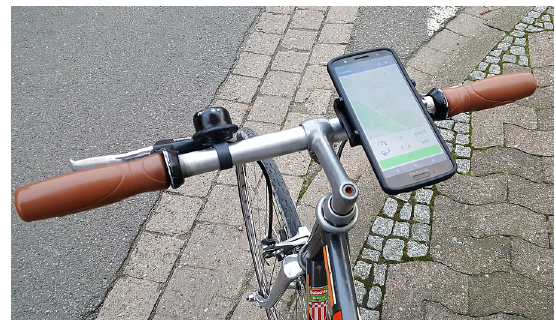
Figure 1. Measurement setup: smartphone with a solid holder attached to a bicycle’s handlebar.